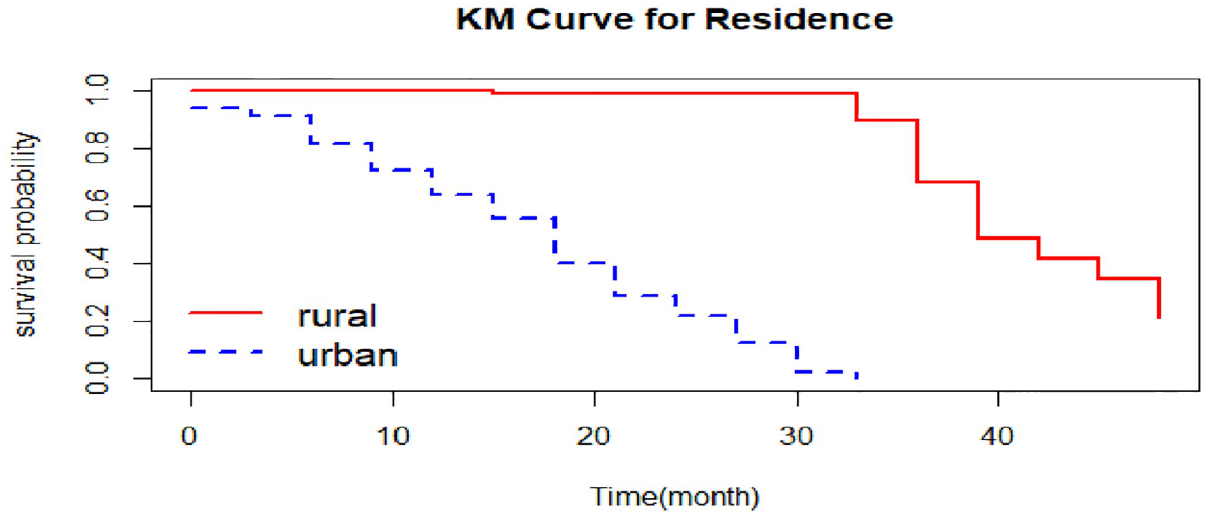
Fig 2. The K-M survival function for complication time of CHF patients by residence.